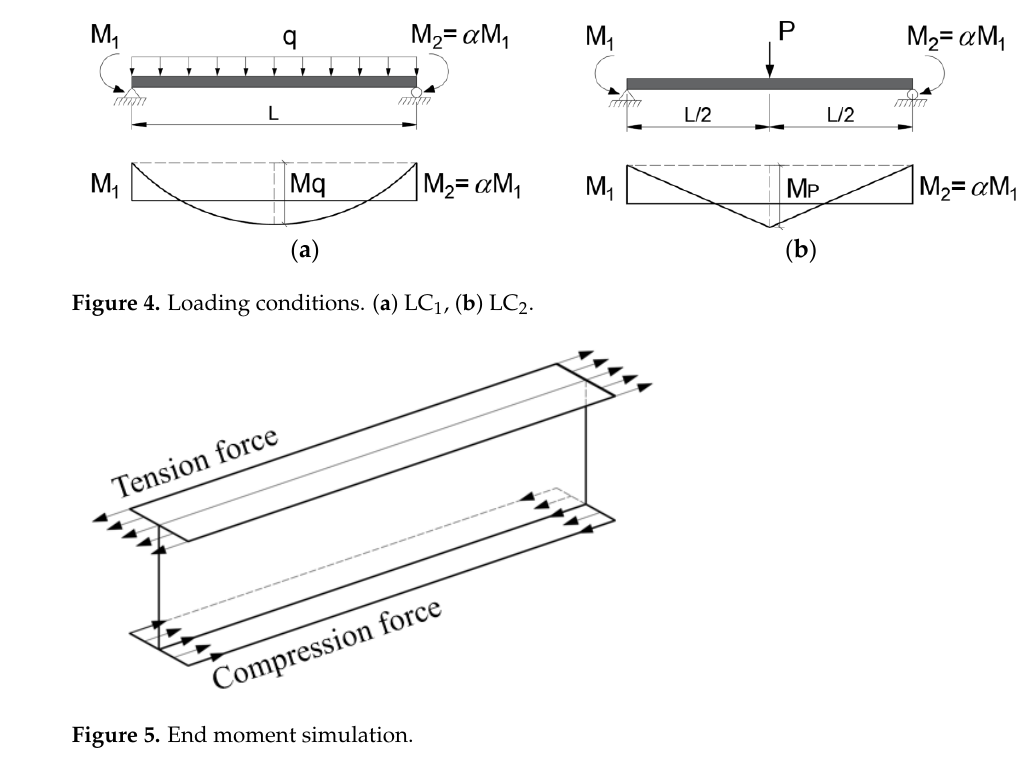
Figure 3. Beam model and boundary conditions.